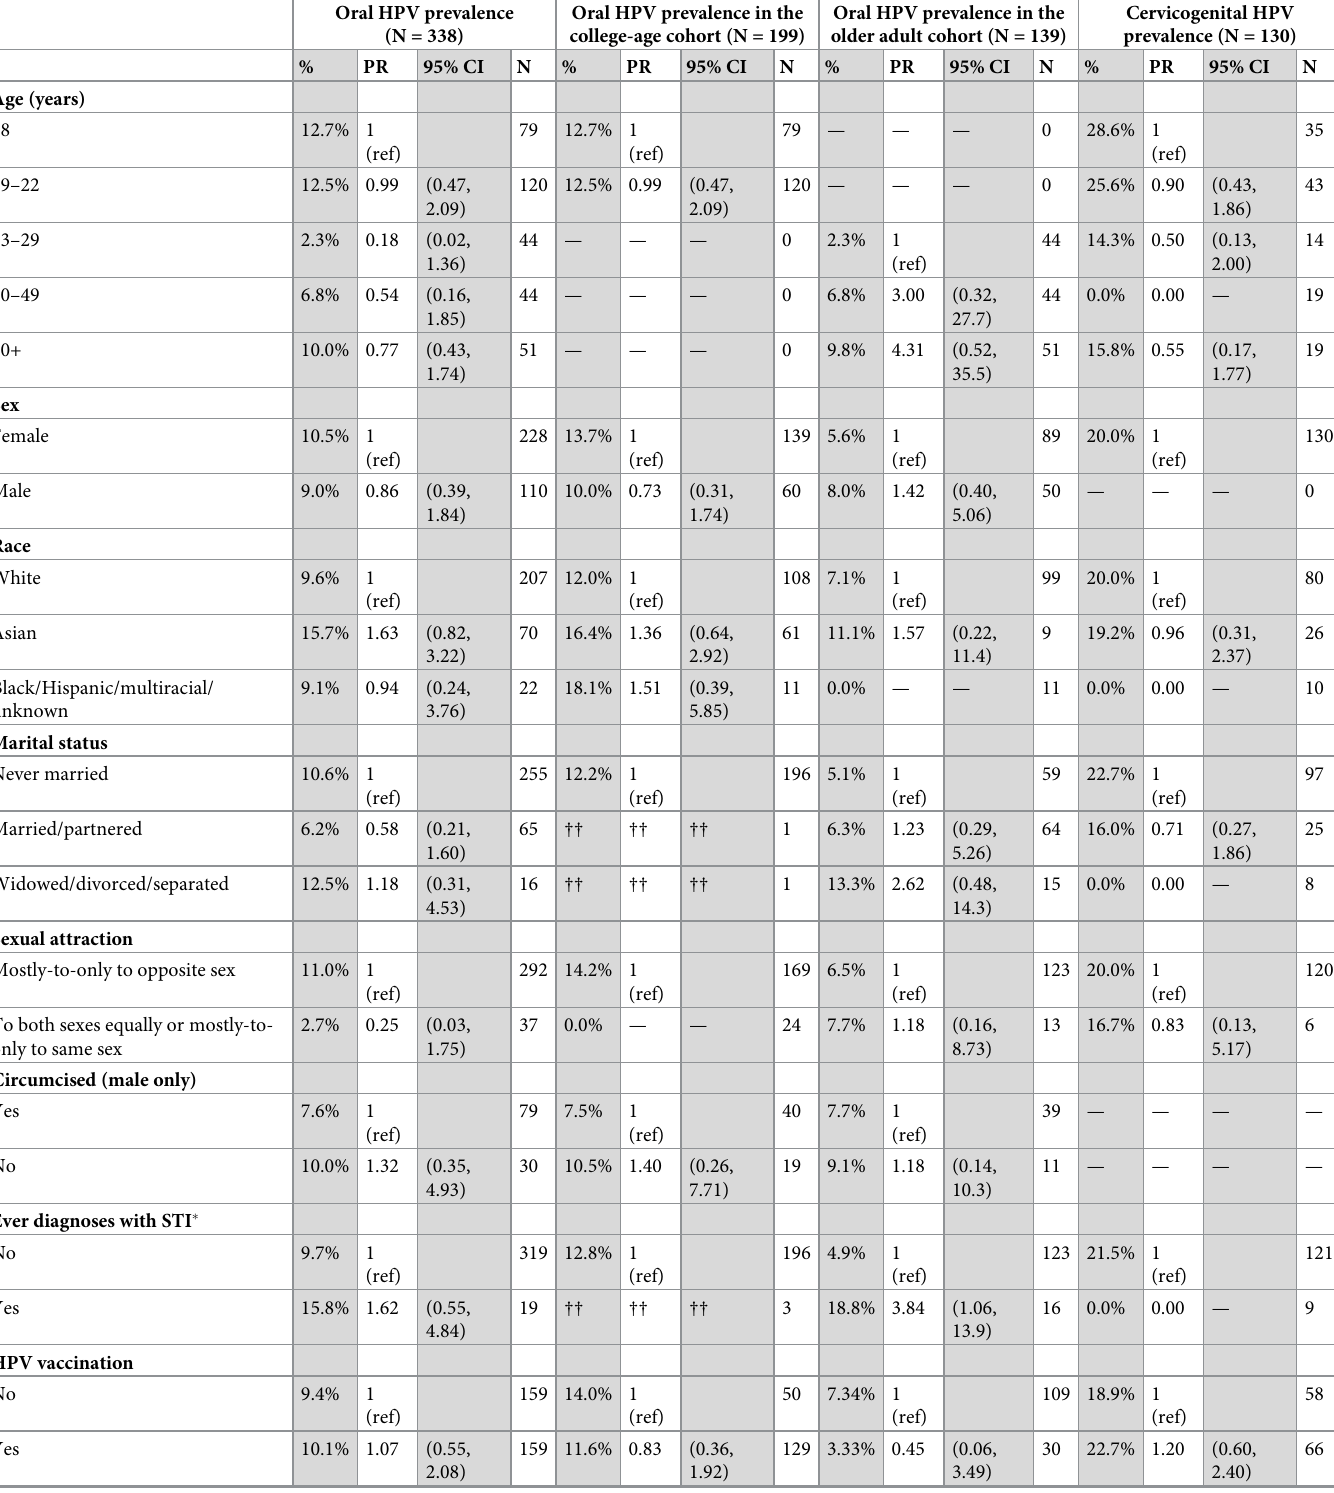
Table 3. Prevalence of oral and cervicovaginal HPV and prevalence ratios (PR) by covariate in the MHOC study (data collected in Ann Arbor, MI, 2015–17, ana- lyzed